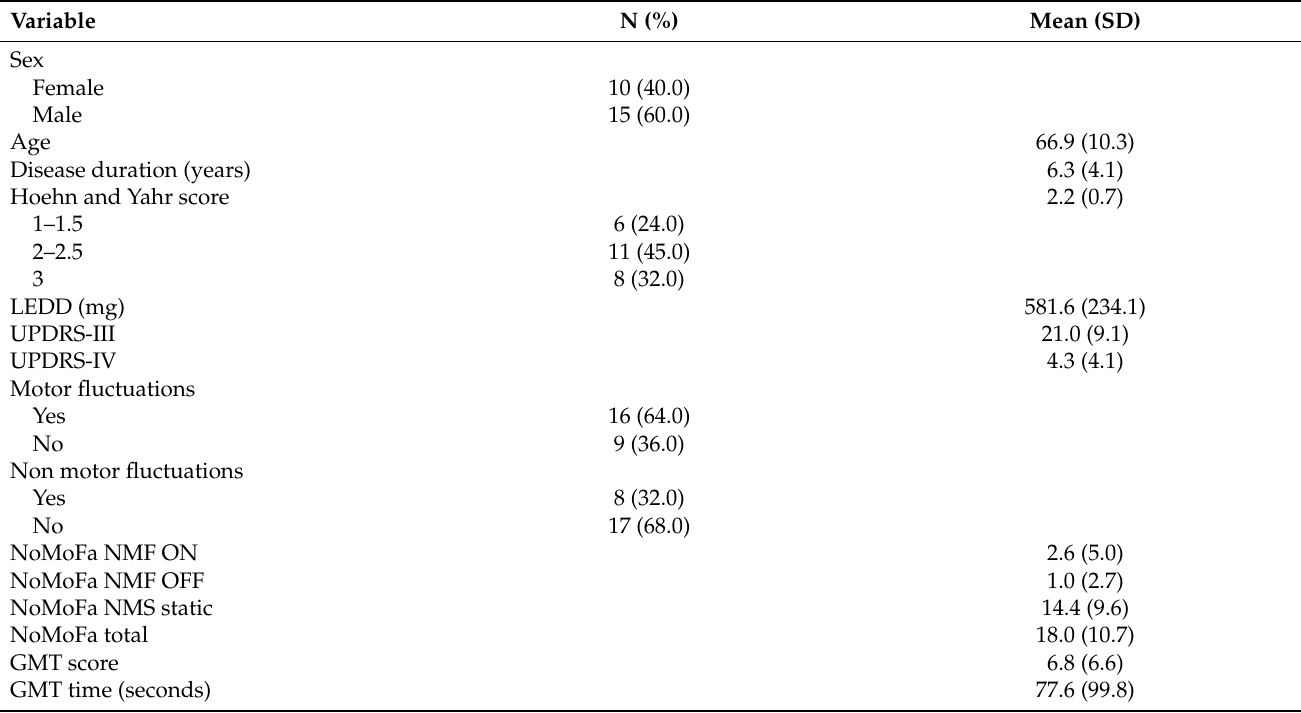
Table 1. Participants’ (N = 25) characteristics and mean NoMoFa and GMT